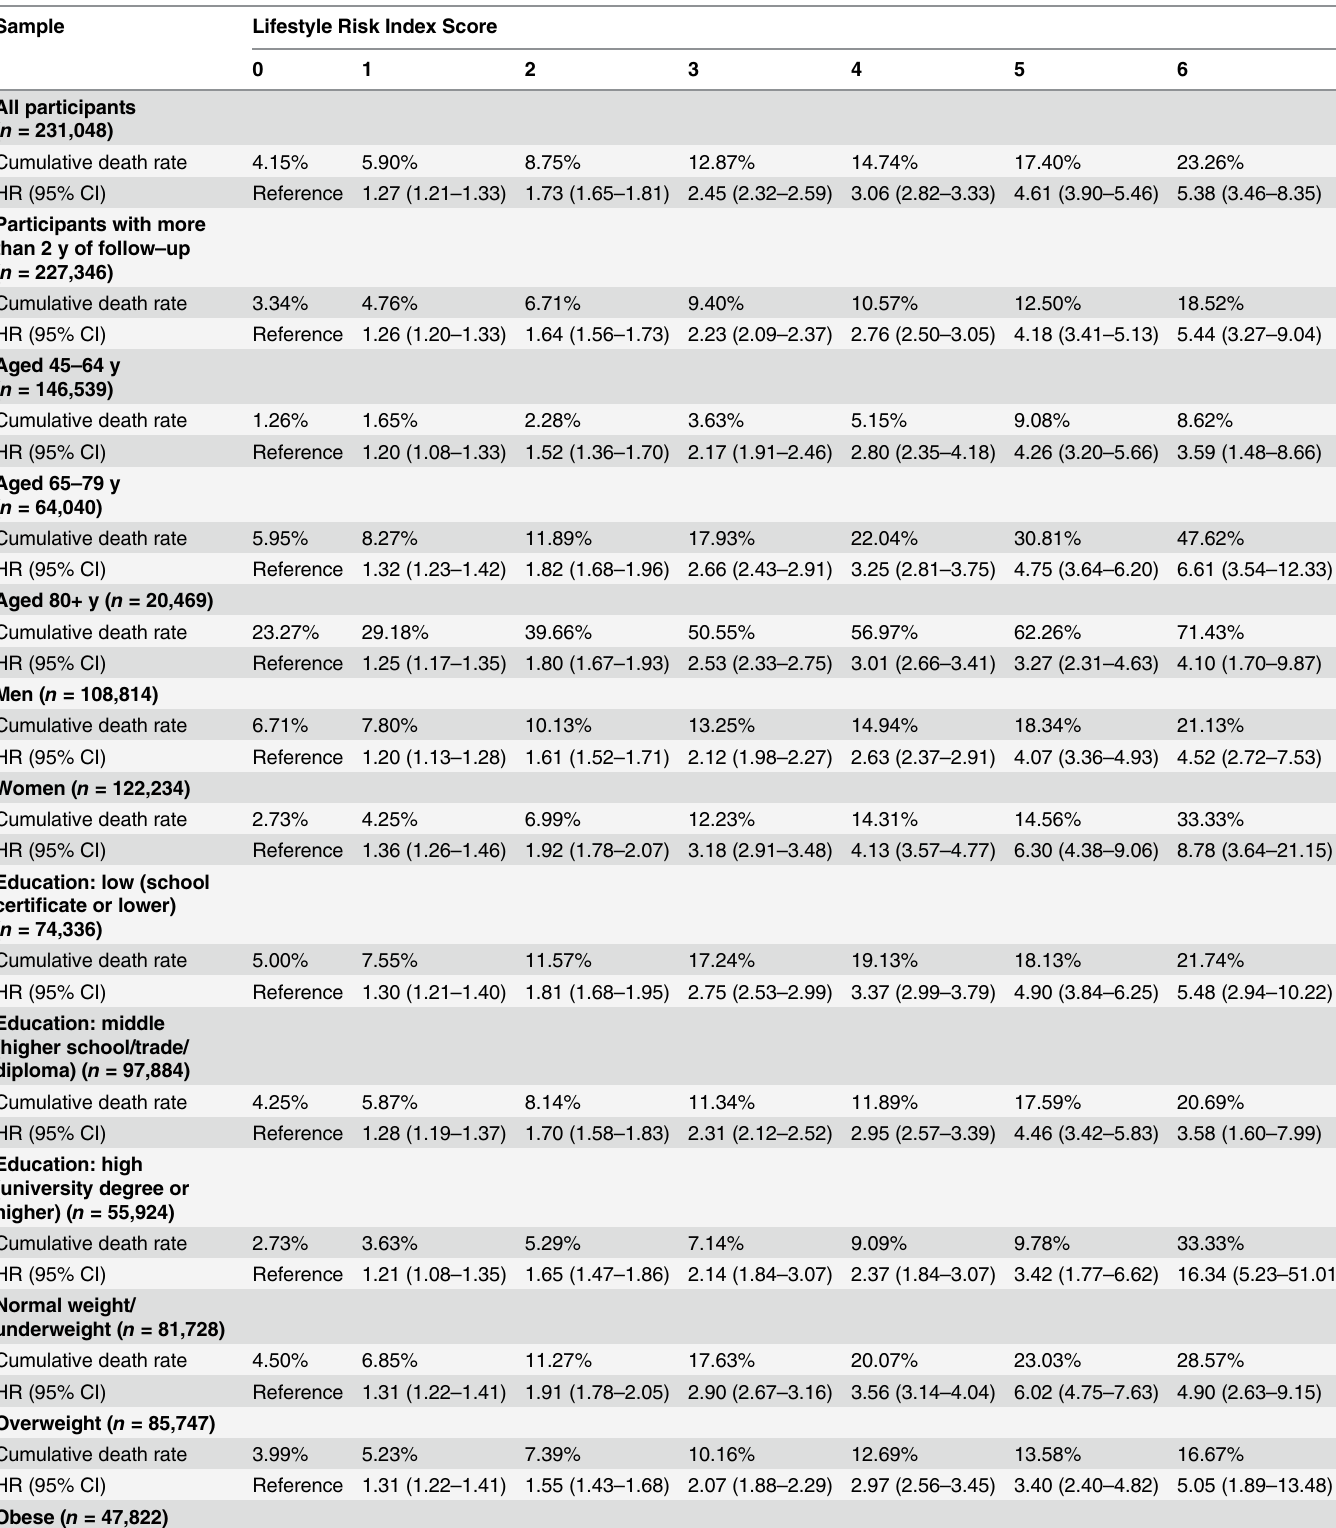
Table 3. Crude cumulative death rates and adjusted hazard ratios for all-cause mortality by lifestyle risk index score among a population-based Australian sample of adults from the 45 and Up Study (2006 – 2014, n =